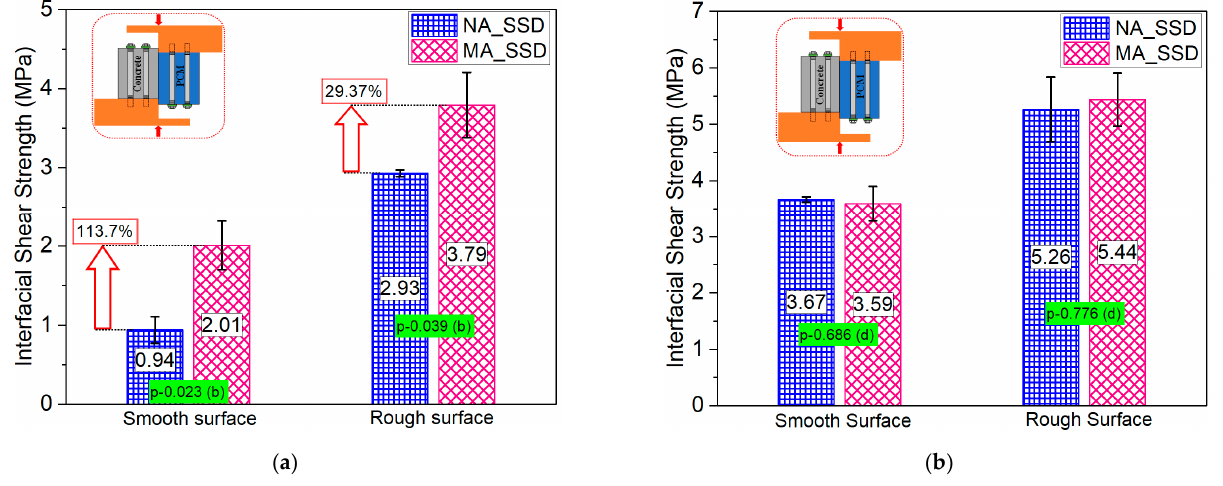
Figure 8. Influence of the addition of 5% silica fume with PCM on the interfacial shear strength. ( a ) Without primer, ( b ) with